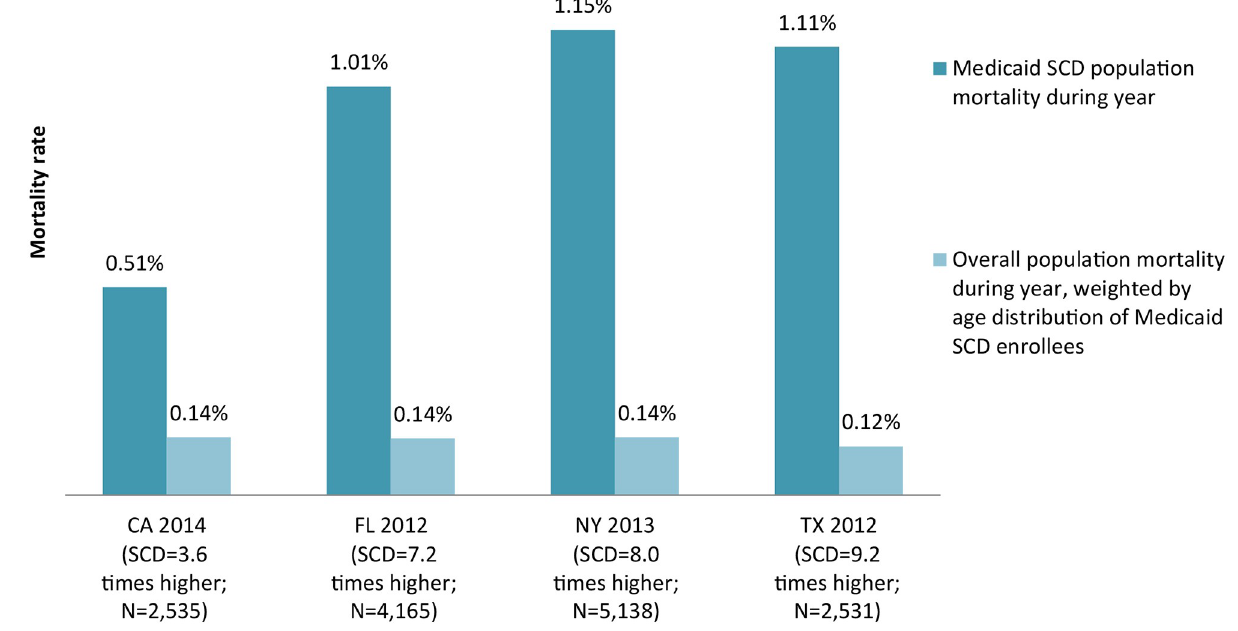
Fig 4. Mortality rate, Medicaid enrollees with SCD relative to age-adjusted population average. SCD is sickle cell disease. https://doi.org/10.1371/journal.pone.0257796.g004 population overall, about one-third have any emergency department visit per year [18, 19]. In comparison, 69 percent to 77 percent of the SCD population had an outpatient emergency department visit (i.e., excluding those that led to an inpatient stay) in the studied states (Fig 3). Similarly, the share of enrollees with an opioid outpatient prescription is about 15 percent for Medicaid overall [20], versus 50 percent or more for the SCD population (Fig 3).